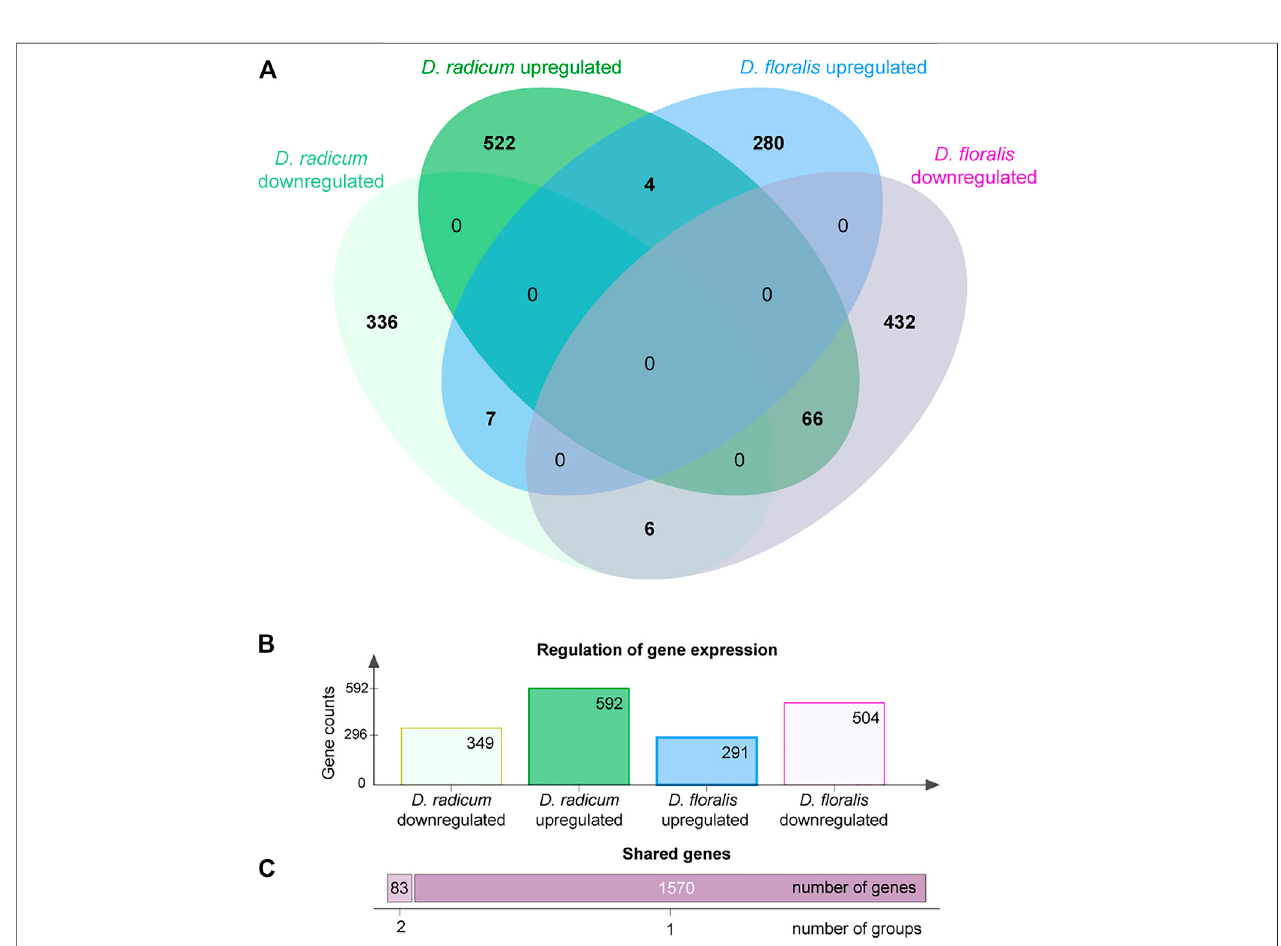
FIGURE 3 | Differentially expressed gene counts in Delia radicum and D. fl oralis larvae in response to 2-phenylethyl isothiocyanate (2PE-ITC) in their diet. Larvae were reared on a semi-arti fi cial diet with zero or 2 µmol 2PE-ITC/g diet for 7 days. Genes were counted as up- or downregulated with a p -value < 0.05 after FDR. (A) Venn-diagramrepresentingthedifferentiallyexpressedgenecountsbetweenbothspecies. (B) Barplotofgenecountsofup-anddownregulatedgenesperspecies. (C) Number of genes responding to 2PE-ITC in one group (dark purple, right bar) or differentially expressed shared by two species-response-direction combinations (light purple, left